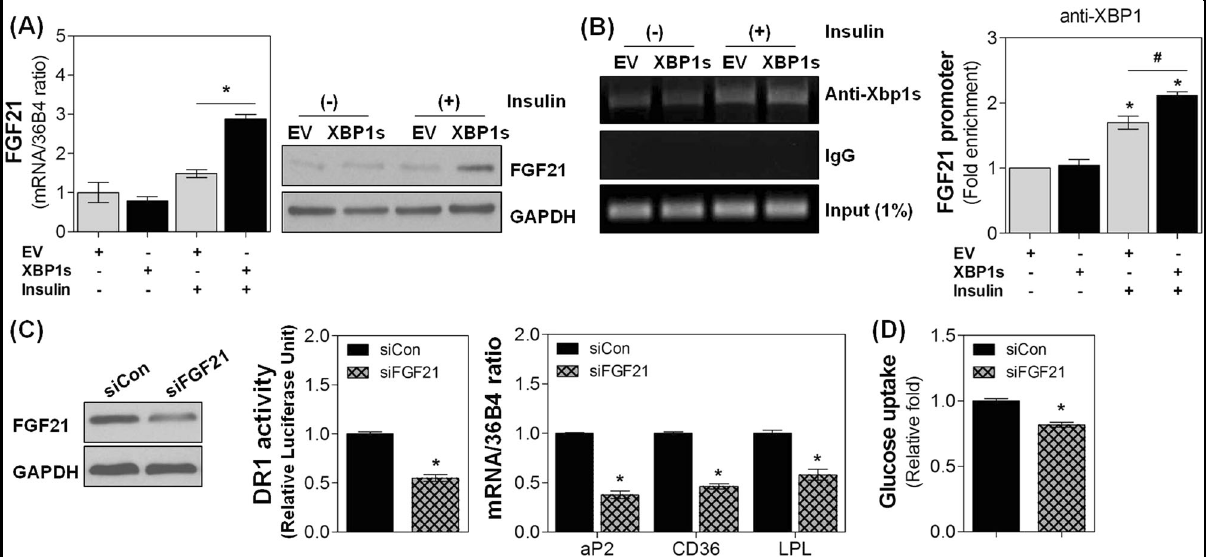
Fig. 3 XBP1s promotes PPAR γ activity through the induction of FGF21 in adipocytes. 3T3-L1 adipocytes were transfected with control vector (EV) or pcDNA3.1-mXBP1s (XBP1s) and treated for 30 min with insulin (1 μ g ml − 1 ) or vehicle as indicated. a FGF21 mRNA and protein levels were analyzed using real-time PCR and immunoblotting. b Chromatin immunoprecipitation was performed to determine the speci fi c binding of XBP1s to the promoter region of fgf21 using XBP1s antibodies (anti-XBP1s). The results were quanti fi ed by densitometry. c , d Effect of FGF21 knockdown on the XBP1-mediated activation of PPAR γ activity and glucose uptake. XBP1s-overexpressing adipocytes were transfected with control (siCon)